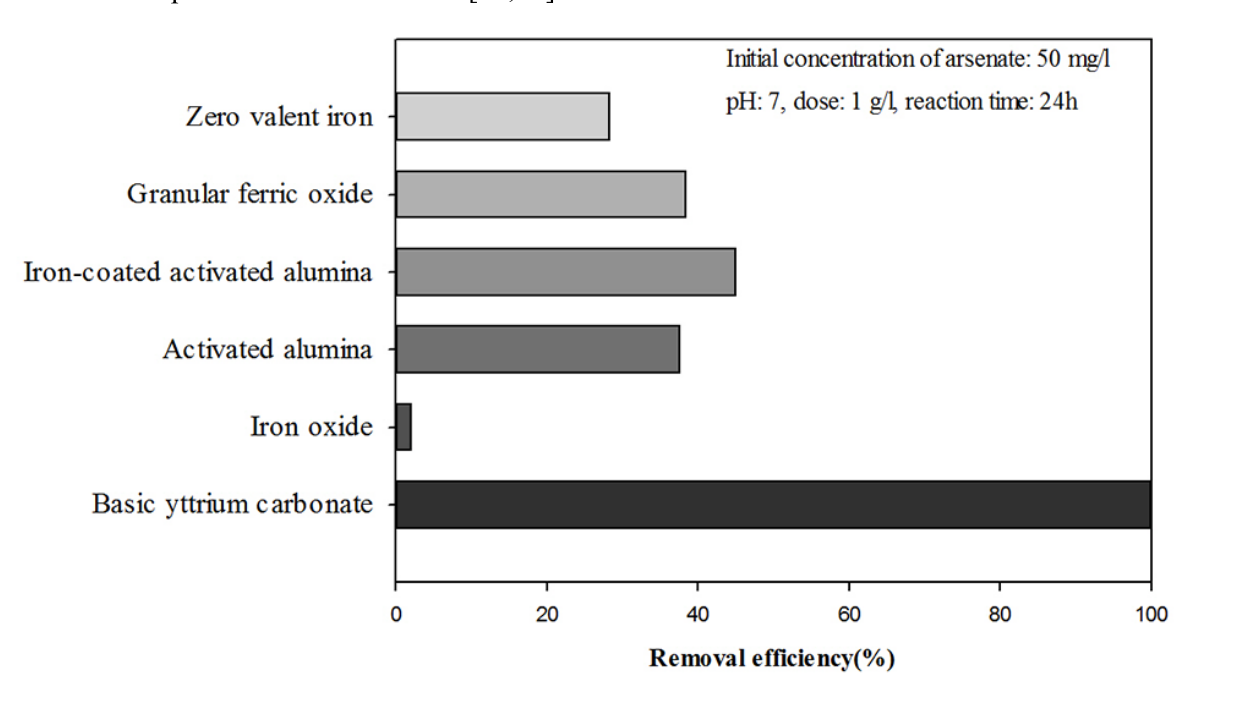
Figure 1. Batch result of basic yttrium carbonate and commercial arsenic